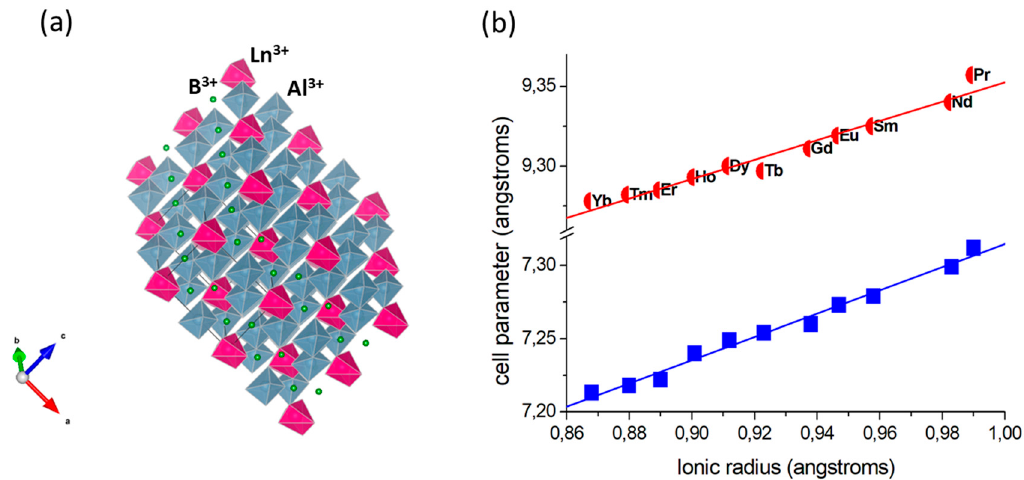
Figure 1. ( a ) LnAB crystal structure (elaborated using the VESTA software [21]); ( b ) variation of the cell parameters (taken from Reference [1]) as a function of the Ln 3+ ionic radii (from Reference [22]).